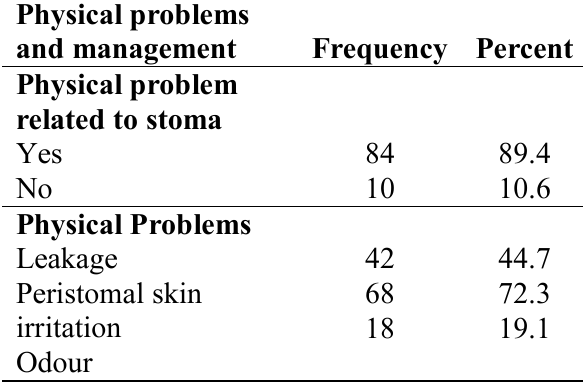
Table 5: Practices regarding Physical Problem and management N